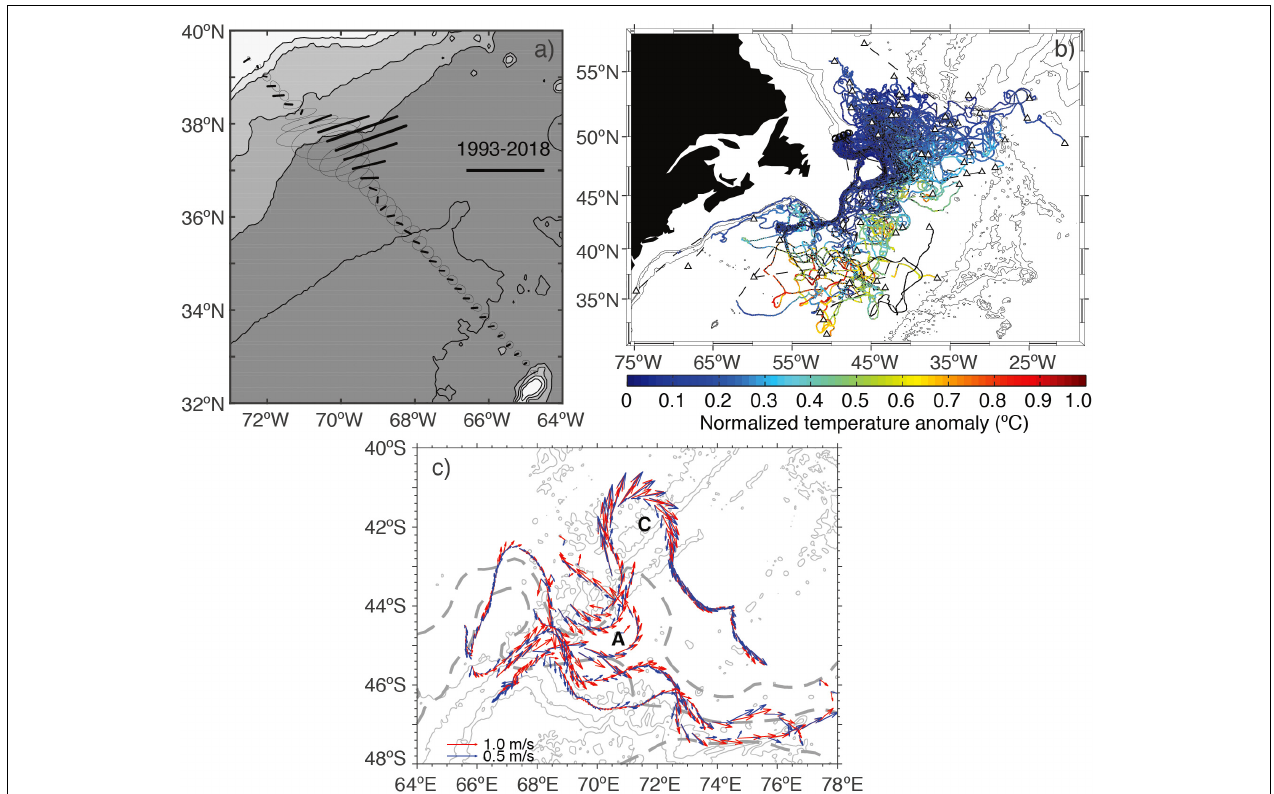
FIGURE 1 | Examples of velocity data. (a) Variance ellipses from repeated Shipboard ADCP transects across the Gulf Stream (e.g. Rossby et al., 2010). Long time-series are needed to show that variability on the flanks is directed toward the center of the Gulf Stream. (b) Map of subsurface pathways from Lagrangian drifters (Bower, pers. comm.). Color shows the normalized temperature anomaly relative to the float’s initial temperature. These 2-year trajectories of RAFOS floats in the subpolar North Atlantic show how they almost exclusively leave the deep boundary-intensified southward current, and instead recirculate in the interior basin. (c) Velocity at 200 dbar (red) and 1500 dbar (blue) from electric field profiling floats in a topographically-induced meander of the Antarctic Circumpolar Current, with branches of the Antarctic Circumpolar Current from concurrent satellite altimetry shown as dashed lines (Phillips, pers. comm.). Note how vertical shear varies consistently for cyclonic (marked “C”) and anticyclonic (marked “A”) curvature, and how surface fronts are often crossed by deep